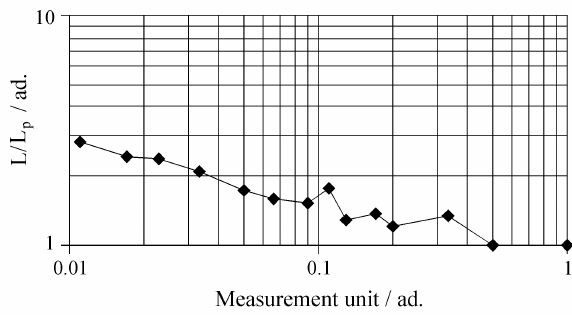
Figure 4. Relative true length versus the measurement unit for a Koch’s line with x = 4 and L p = 0,30 m (ad. = non-dimensional) 10 .